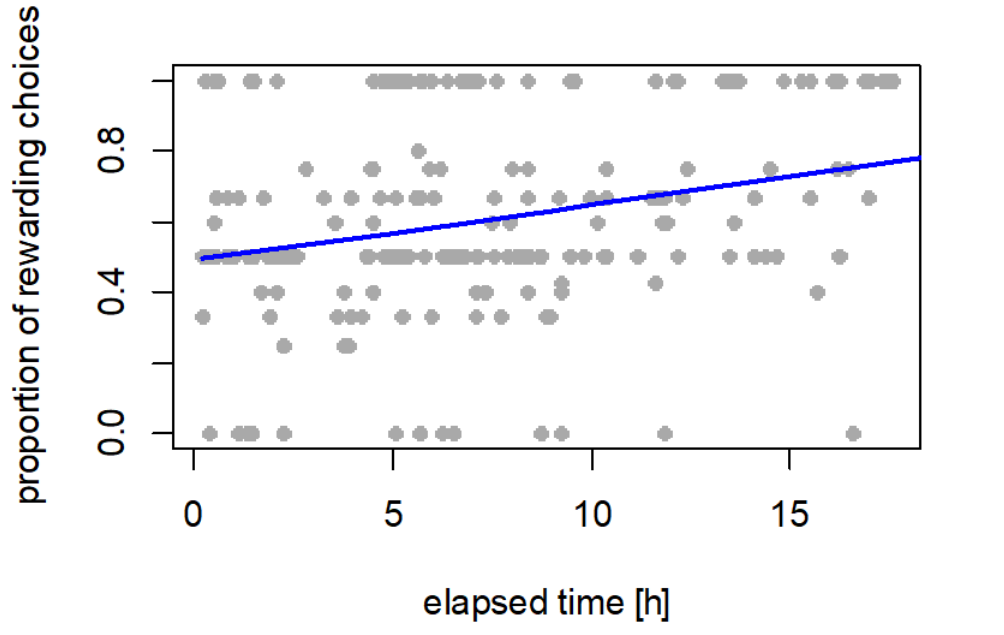
Figure 3. Proportion of rewarding choices (= UV-reflective flowers) made by sunbirds in response to elapsed time in hours, CI in light blue. Observations were conducted over three days (Day 1: 0- 2.5 hours, Day 2: 2.5-11 hours, Day 3: 11-16 hours).